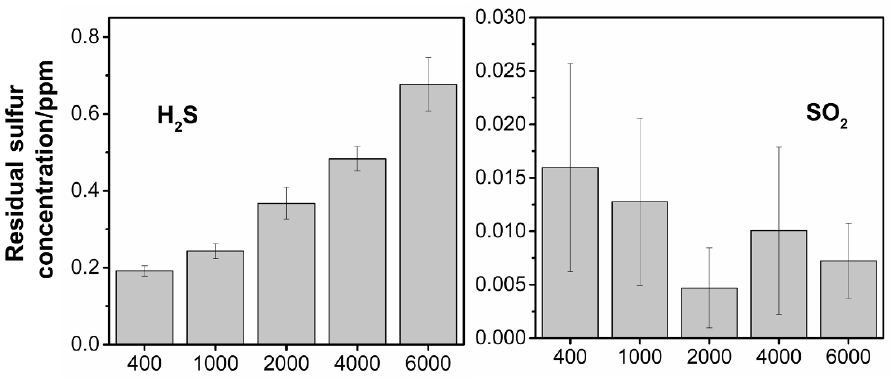
Figure 4. Residual sulfur concentrations in the gas phase measured with various H 2 S concentrations with the sorbent 15Mn8Mo at 600 °C with the fixed space velocity of 60,000 mL gas /g sorbent h.